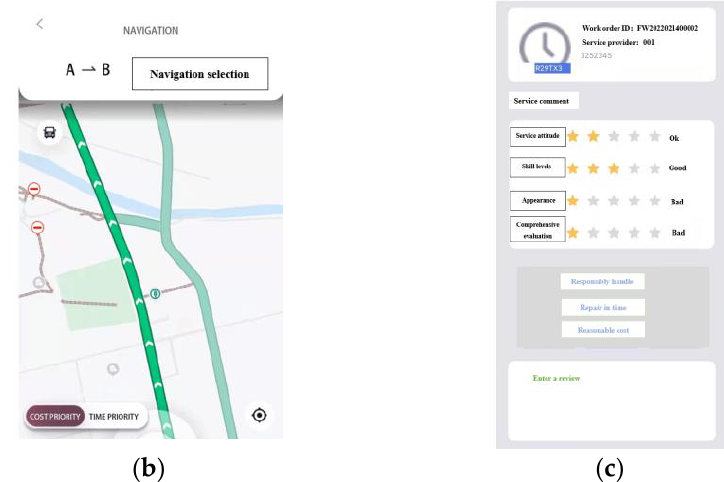
Figure 8. The function of the handheld terminal for agricultural machinery users. ( a ) User service report for repair; ( b ) Service station maintenance path planning; and ( c ) Service evaluation after maintenance.